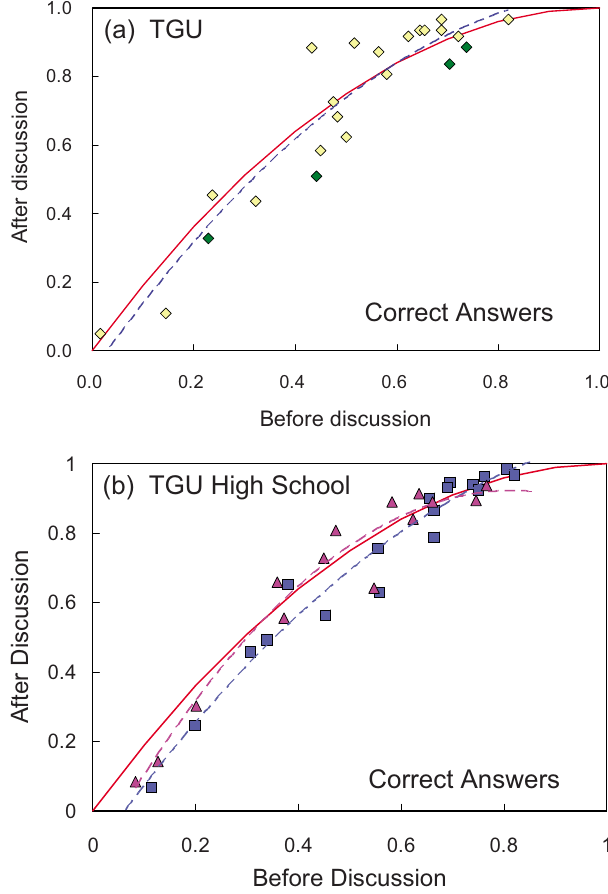
FIG. 1. (cid:1) Color (cid:2) The normalized number of correct answers after discussion versus before discussion for (cid:1) a (cid:2) a university course of introductory mechanics and (cid:1) b (cid:2) high-school physics courses. The red solid lines represent the theoretical curve of Eq. (cid:1) 8 (cid:2) . In (cid:1) a (cid:2) , the blue broken line represents the best fitting curve in the second-order polynomial approximation. The four green points represent data as- sociated with Newton’s third law. In (cid:1) b (cid:2) the violet and blue points correspond to the data from 2008 classes and 2009 classes, respec- tively. The violet and blue broken lines are corresponding best fit- ting